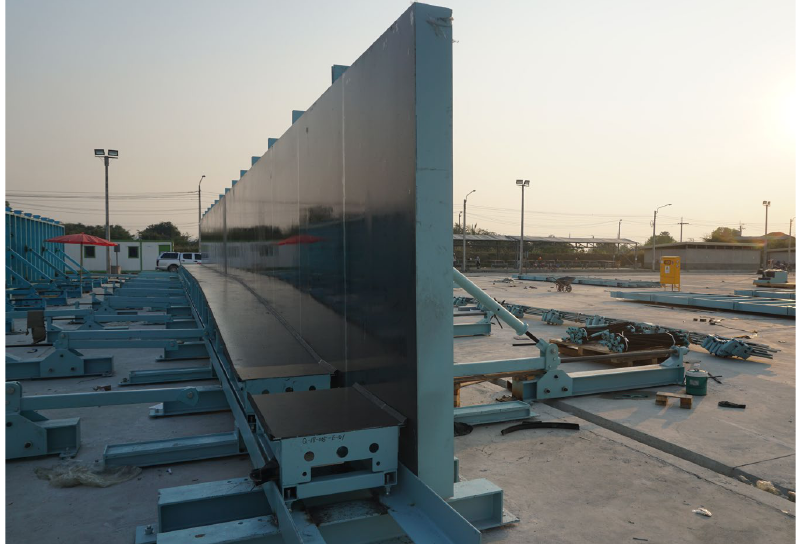
Figure 5. Typical view of formwork.